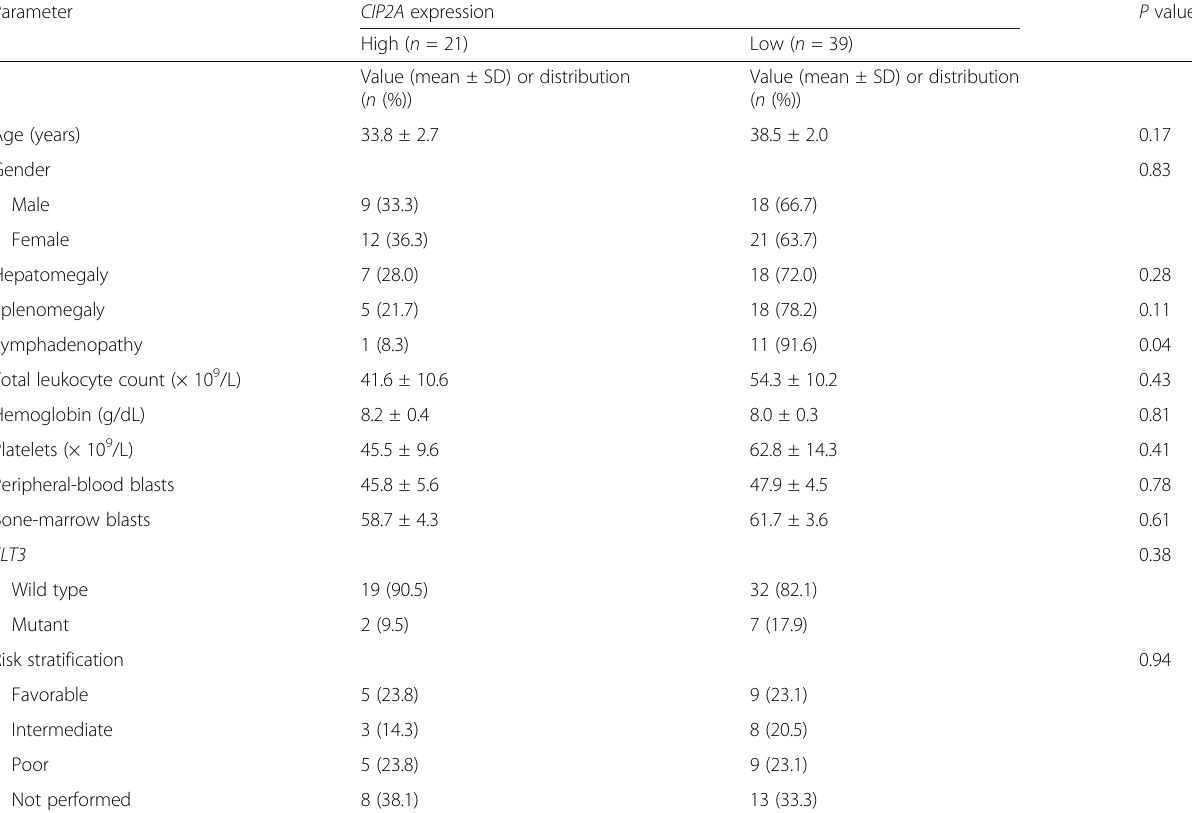
Table 2 Association between CIP2A expression in patients with acute myeloid leukemia and demographic characteristics, clinical and laboratory data, and risk